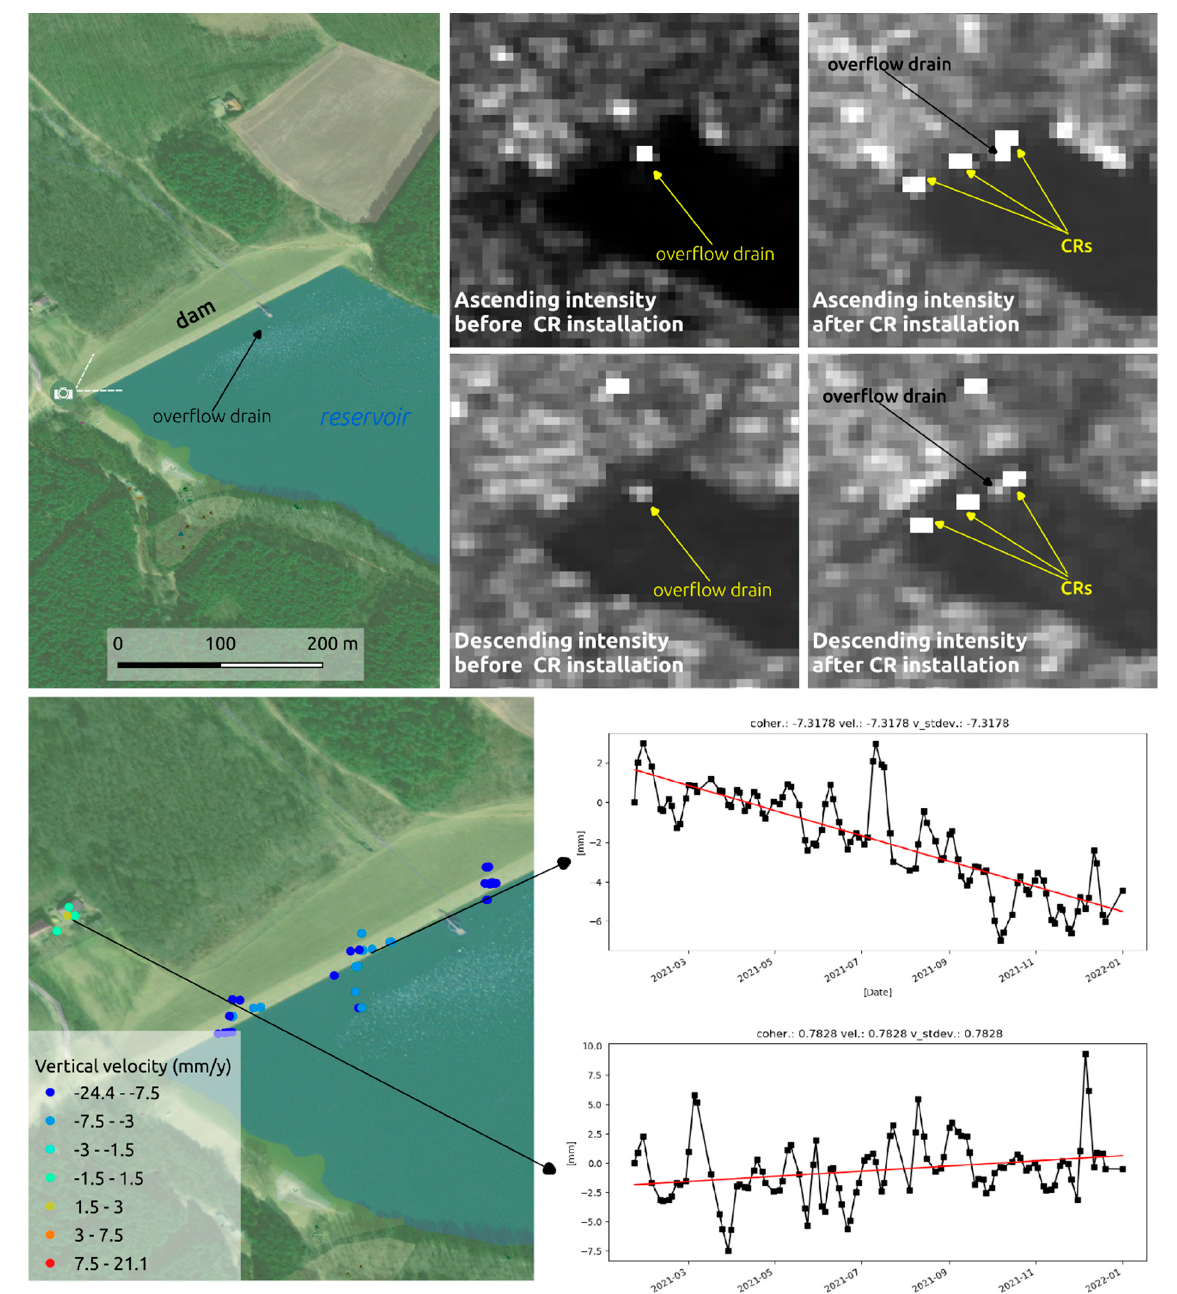
Figure 7. Improving the detectability of a dam with three pairs of CRs. Top left figure = overview of the dam from Google satellite images, top right figures = coherence of the site from ascending and descending geometry of S1, bottom figures = combined vertical PS measurements of the dam after CR installation and time series of one of the CRs and an adjacent stable building. (Please note, that if the area was not showing any PS where now the CR is, then the little new clusters of PS might relate with the side-lobes of the CR. In such a case, they would present the same displacement rate of the main